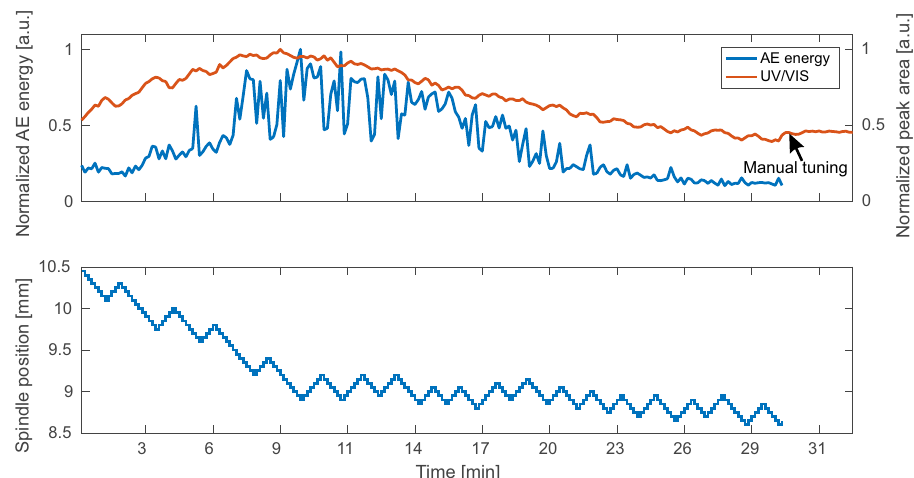
Figure 6. Automatic positioning results: experimental run